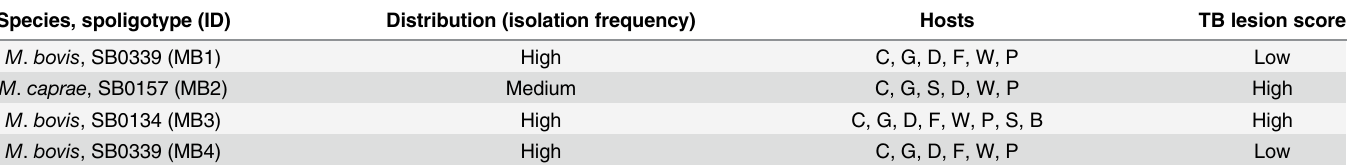
Summary of the results obtained after the analysis of different MTBC spoligotypes ful fi lling selection criteria (i-iii) described in Materials and Methods. The spoligotypes SB0134, SB0339 and SB0157 were among the most frequent spoligotypes found in both livestock and wild ungulates in the study area. The spoligotypes SB0134 and SB0339 clustered in space and time and showed high abundance. Findings in Iberian red deer showed a higher lesion score caused by spoligotype SB0134 when compared to spoligotype SB0339 while these spoligotypes and particularly SB0134 and SB0157 suggested an association with high TB severity in Eurasian wild